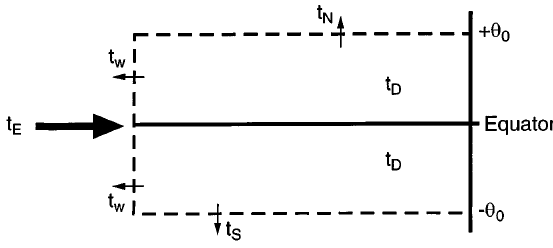
Fig. 1. Energy flux and energy dissipation generated from h (cid:136) h 0 to h (cid:136) (cid:255) h 0 . t N , t S and t E represent, respectively, the northward, southward and the incoming energy fluxes. The energy dissipation is represented by t